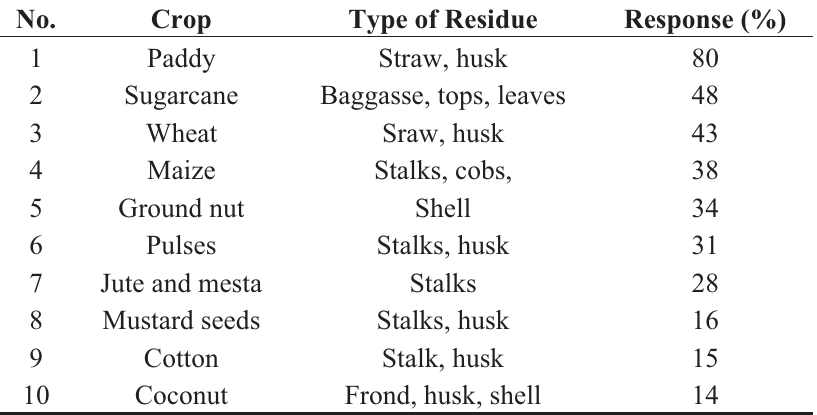
Table 1. Promising crops and their residue for bioenergy production ( N =